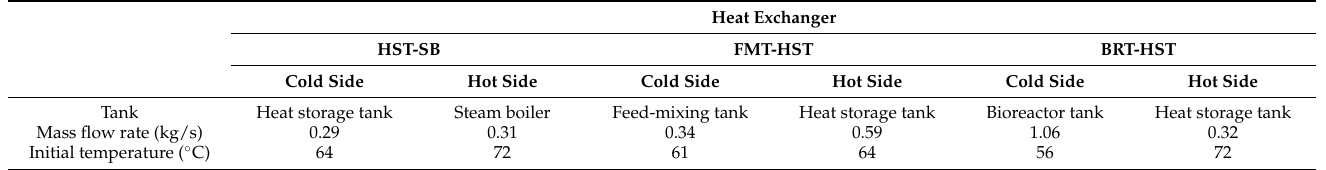
Table 2. Heat-exchanger operating conditions.